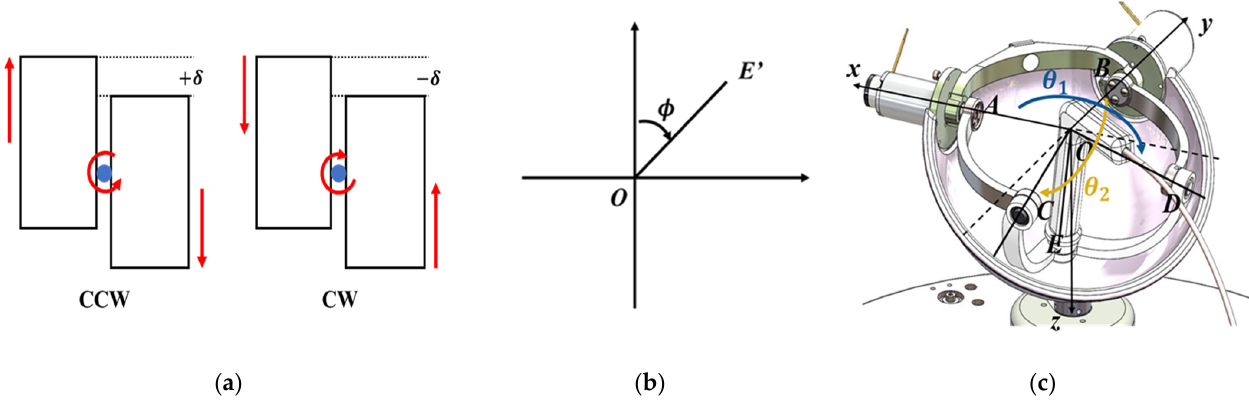
Figure 8. Concept of rotation notification. ( a ) Roller cassettes depending on rotational direction. ( b ) Top view (projection on x–-y plane) of the master grip. ( c ) Isometric view.